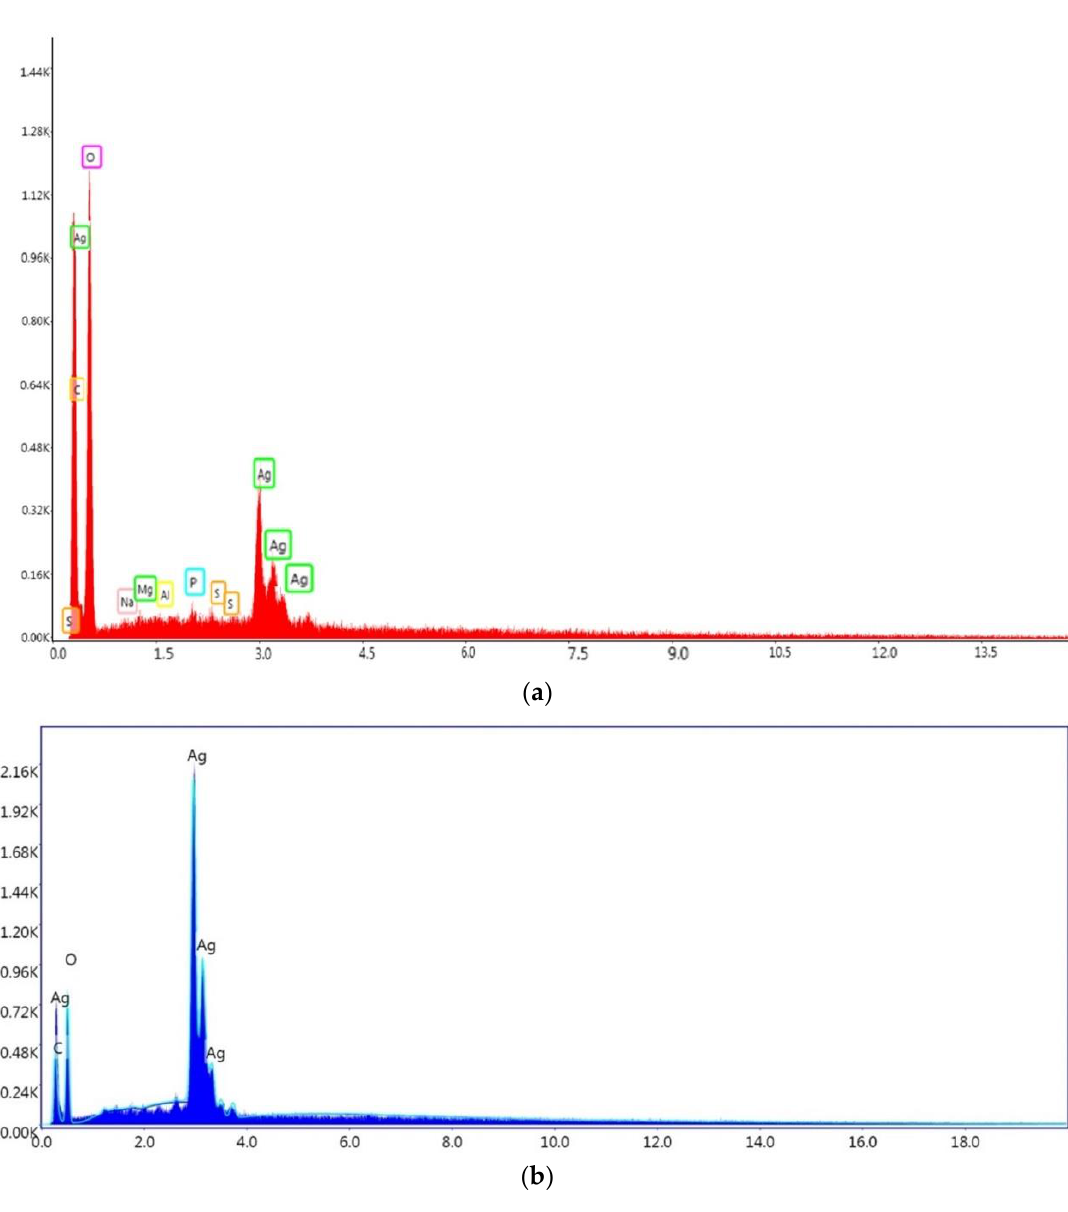
Figure 14. ( a ) EDX spectrum of phytocarrier system. ( b ) EDX spectrum of phytocarrier system (O K/C K/AgL phase).